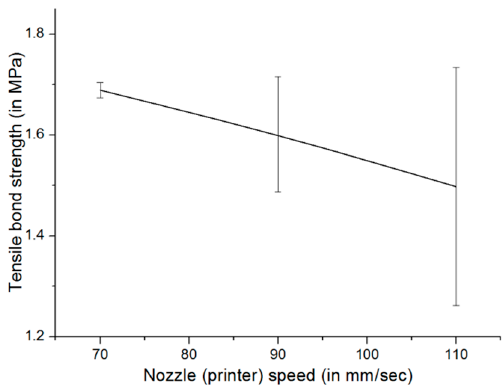
Figure 17. Effect of nozzle speed on tensile bond strength. Reprinted with permission from ref. [43]. Copyright 2017 Elsevier Ltd.